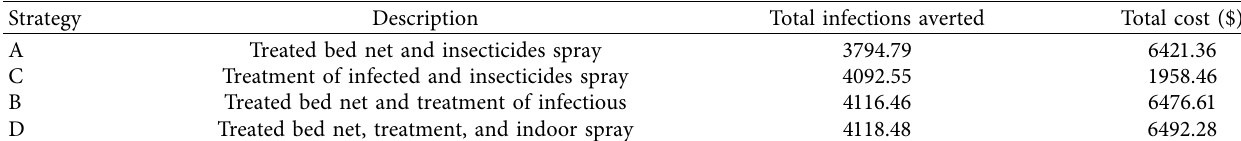
Table 5: Number of total infections saved and cost averted for all strategies.